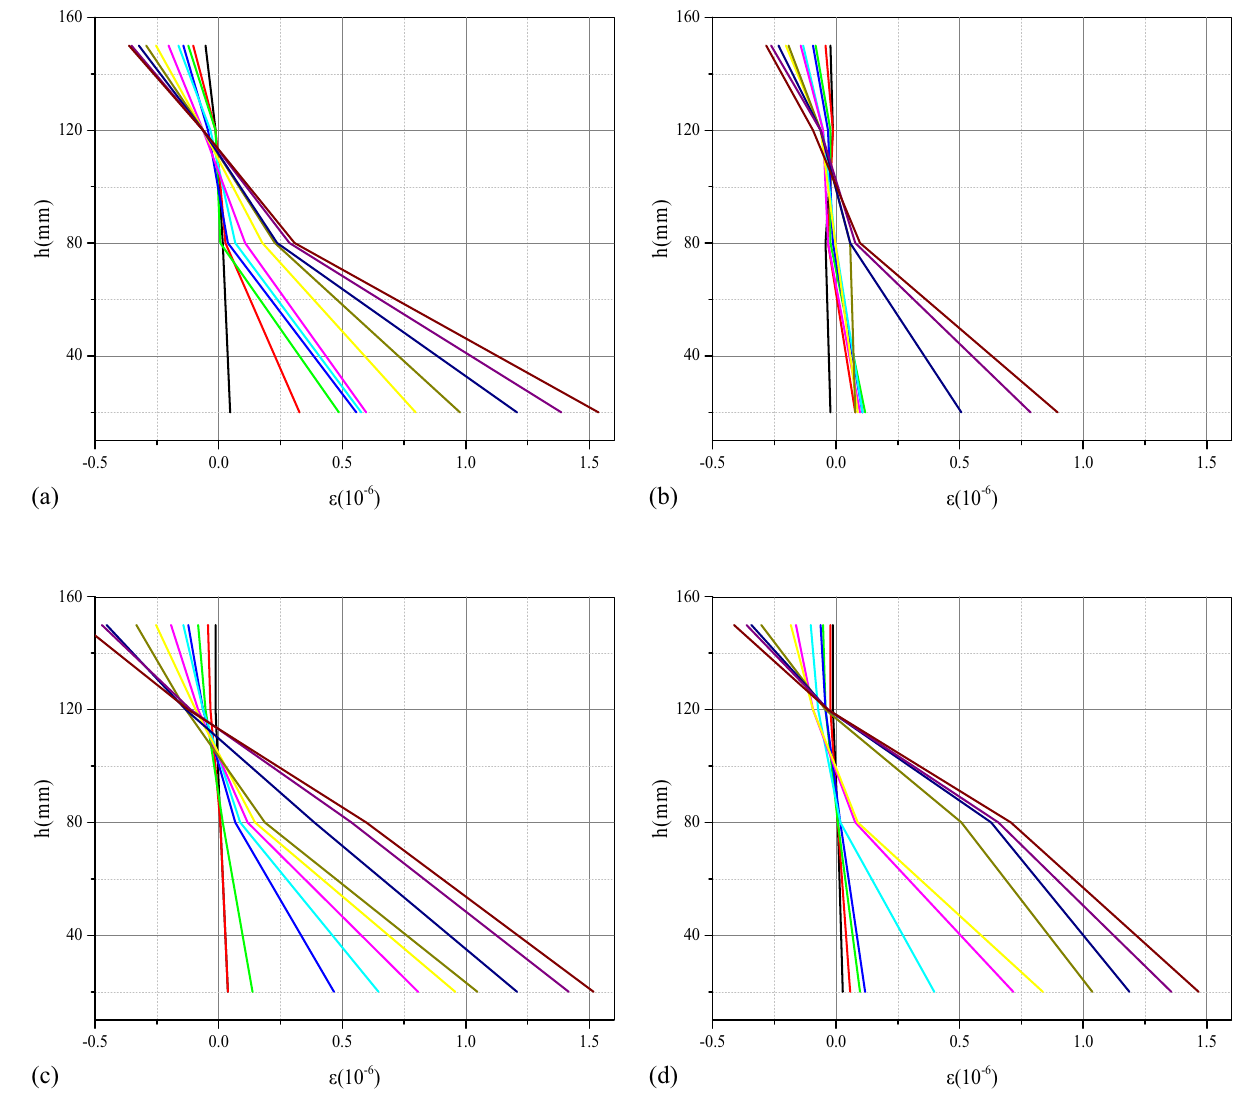
Figure 9: Strain at mid - span section of the concrete beam under di ff erent load levels before the beam fails. ( a ) B, ( b ) P, ( c ) PS, and ( d )